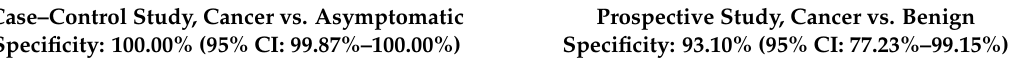
Table 2. Summary of clinical validation studies. The table provides the summary of both clinical validation studies. The stringent cross-validation design of the case–control (cancer versu. healthy) study yields a range of sensitivities and accuracies, the median of which are reported along with the 95% confidence interval (CI) for the median. Cancer samples (cases) with equivocal findings are considered as positive for determination of sensitivity and accuracy. The prospective clinical study evaluates the performance of the test among a cohort of symptomatic cases who were eventually diagnosed with breast cancer, or benign conditions of the breast. In this study, benign samples with equivocal findings are considered as false positives for determination of specificity and accuracy. Additional analyses are provided in Supplementary Tables